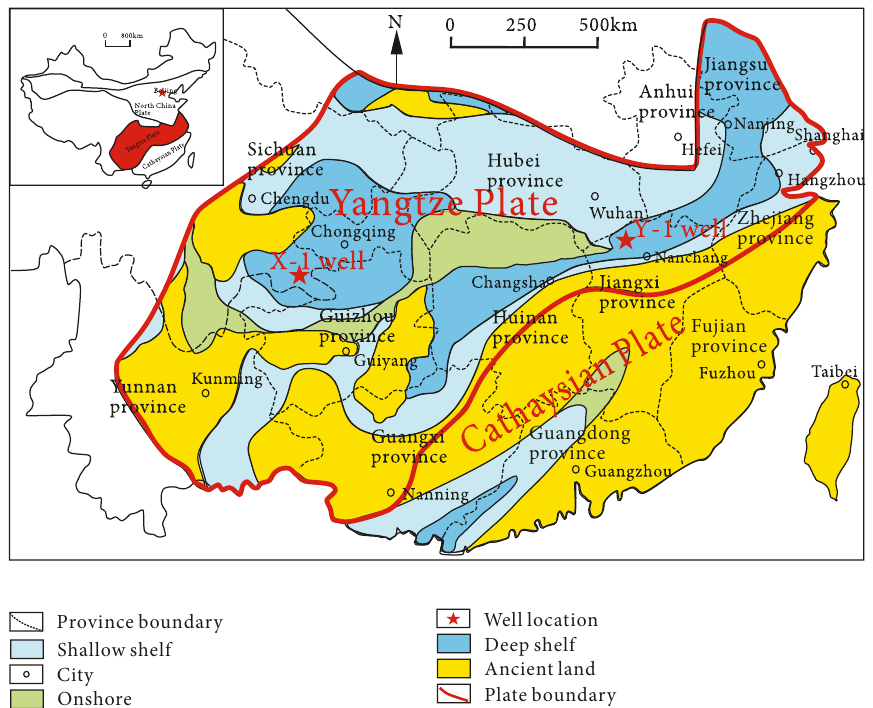
Figure 1: Sedimentary characteristics of the late Ordovician-early Silurian in southern China. The X-1 well is located in the upper Yangtze region, which is a deep-water shelf environment that is surrounded by ancient land; the Y-1 well is located in the lower Yangtze region, close to the junction of the Yangtze Plate and the Cathaysian Plate [24, 25,